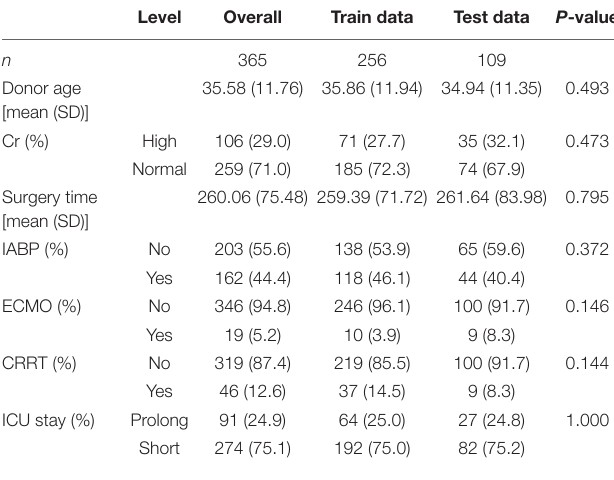
TABLE 2 | The entire dataset was split into a training set and testing set